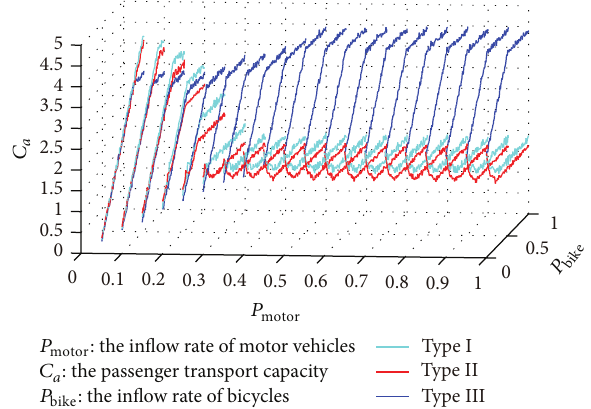
Figure 7: Passenger transport capacity 𝐶 𝑎 versus the inflow rates 𝑃 and 𝑃 at three types of bus motor bike